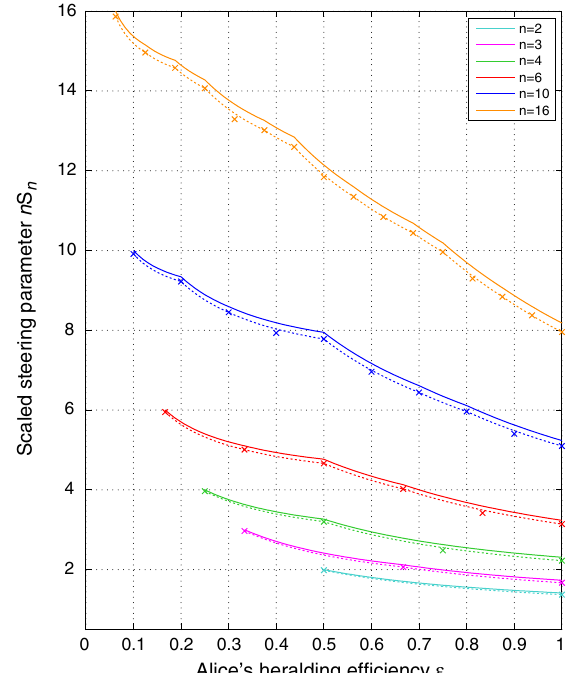
FIG. 7. Experimental data for a dishonest Alice. The solid curves are the bounds C n ð (cid:2) Þ on S n , for n ¼ 2 , 3, 4, 6, 10, and 16. The vertical axis shows a scaled version of the steering parameter, n S n , purely for clarity when comparing the different bounds. The same-colored (cid:7) s correspond to the experimentally observed steering parameter S cheat n obtained by a cheating Alice using a deterministic strategy. The dashed lines, derived from the data points, show the maximum S cheat n that Alice could achieve by combining two different deterministic strategies to simulate a heralding efficiency (cid:2) . Error bars are smaller than marker